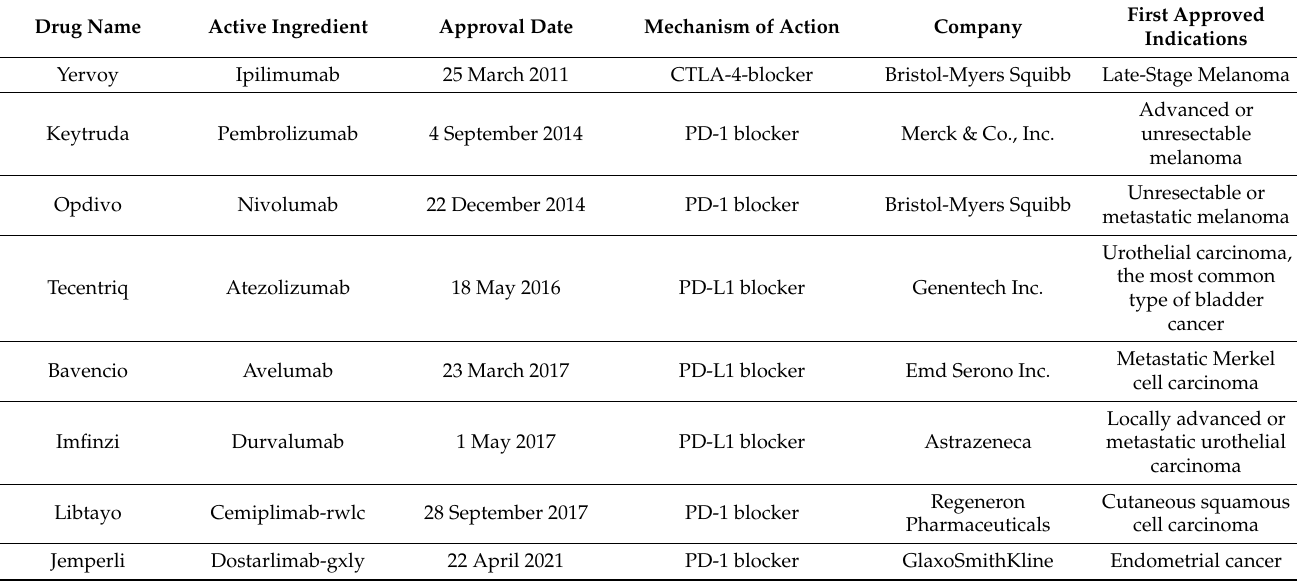
Table 1. FDA approvals of ICIs from January 2011 to May